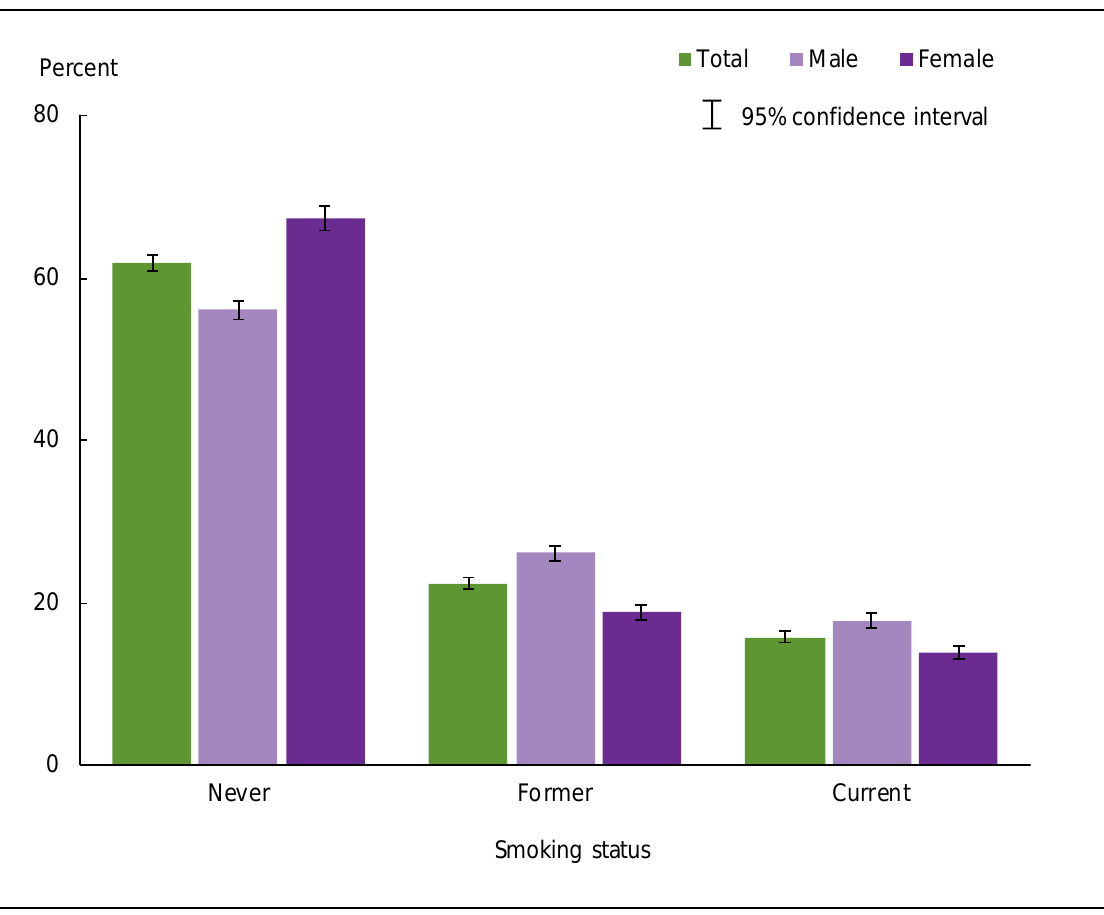
Figure 8.2. Percent distribution of cigarette smoking status among adults aged 18 and over, by sex: United States,